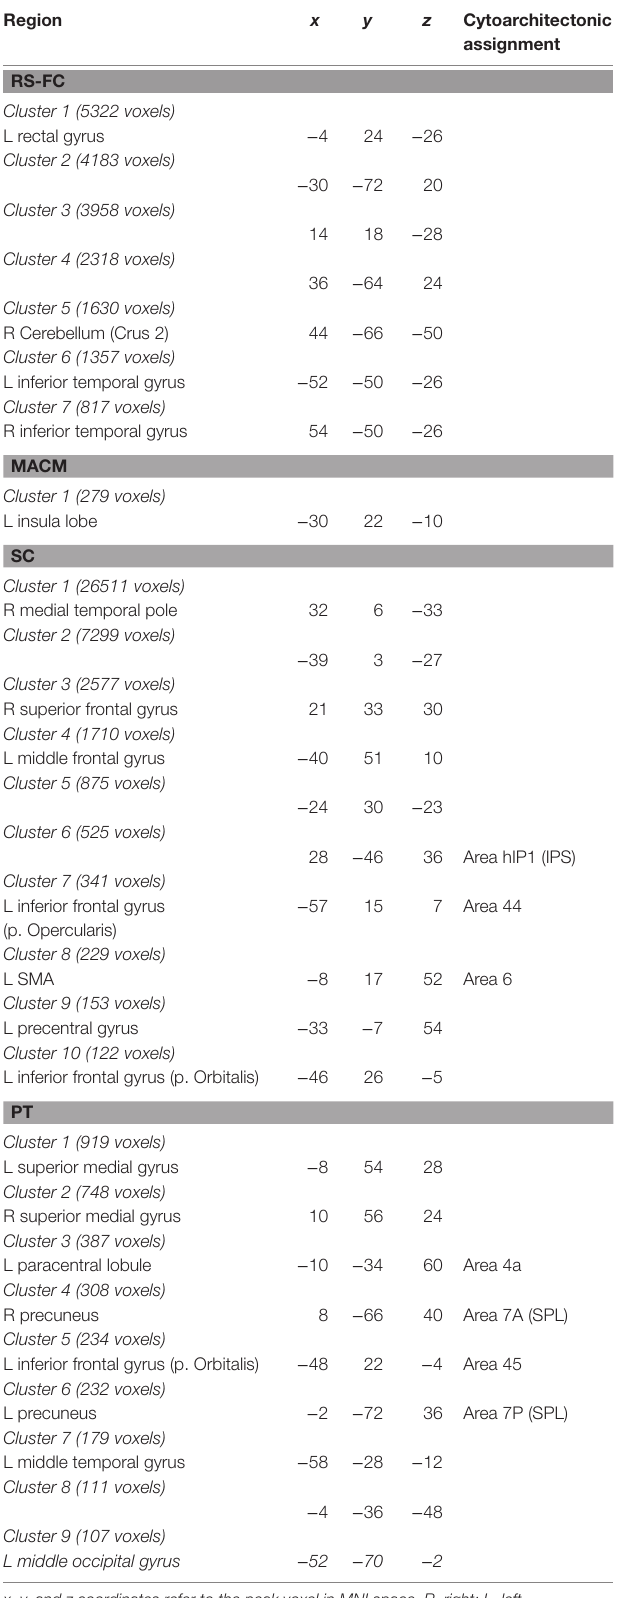
TaBle 3 | specifically present connectivity of iFs